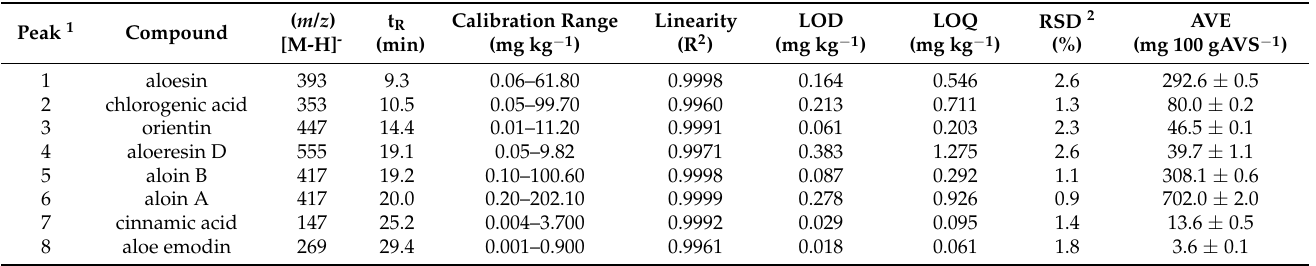
Table 5. Phenolic compounds identified in AVE by HPLC-MS, analytical figures of merit and quantification results by